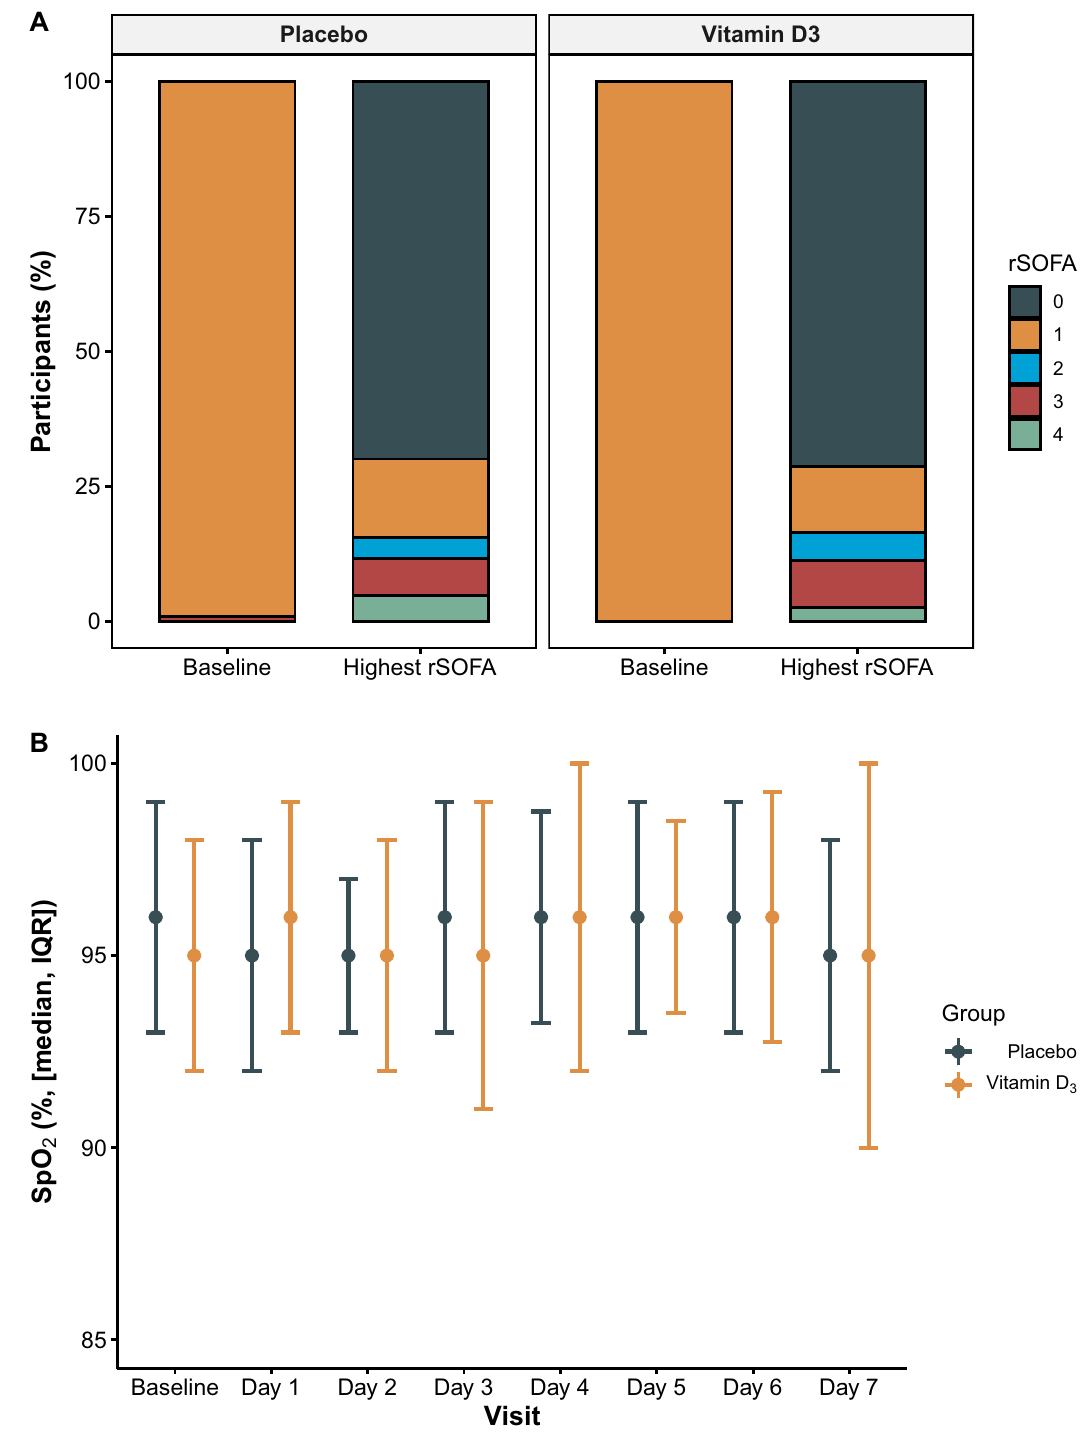
Fig 2. Changes in rSOFA scale from baseline to wort value recorded (A), and SpO2 during first week (B).